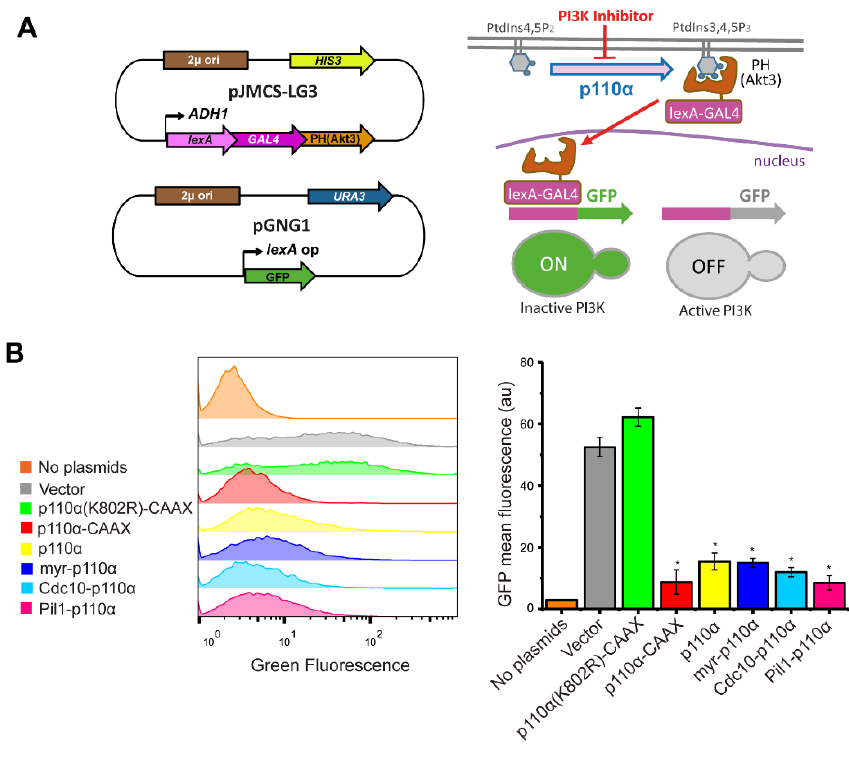
tor; error bars represent